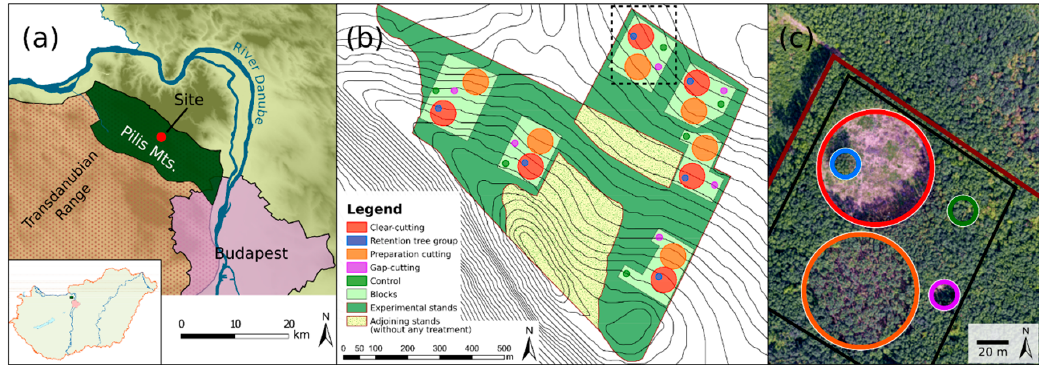
Figure 1. The study site of the Pilis Experiment in Northern Hungary. ( a ) Site location (47°40 ′ N, 18°54 ′ E) in the Pilis Mountains. ( b ) Experimental design showing the five treatments replicated within six blocks. ( c ) Aerial photograph revealing a block with the applied forestry treatments: clear-cutting (red) with a retention tree group (blue); preparation cutting (orange); gap-cutting (purple); and the control (green). Drone photo was taken by Viktor Tóth.